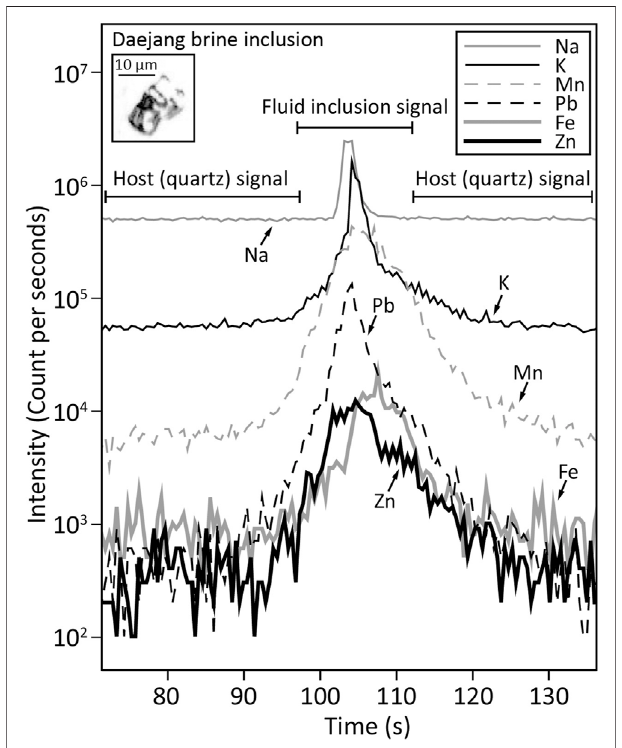
FIGURE 8 | Transient signals of LA-ICP-MS of brine inclusions analysis (Daejang quartz veins) showing signals for Si, Na, Mn, Pb, Fe, and Zn.